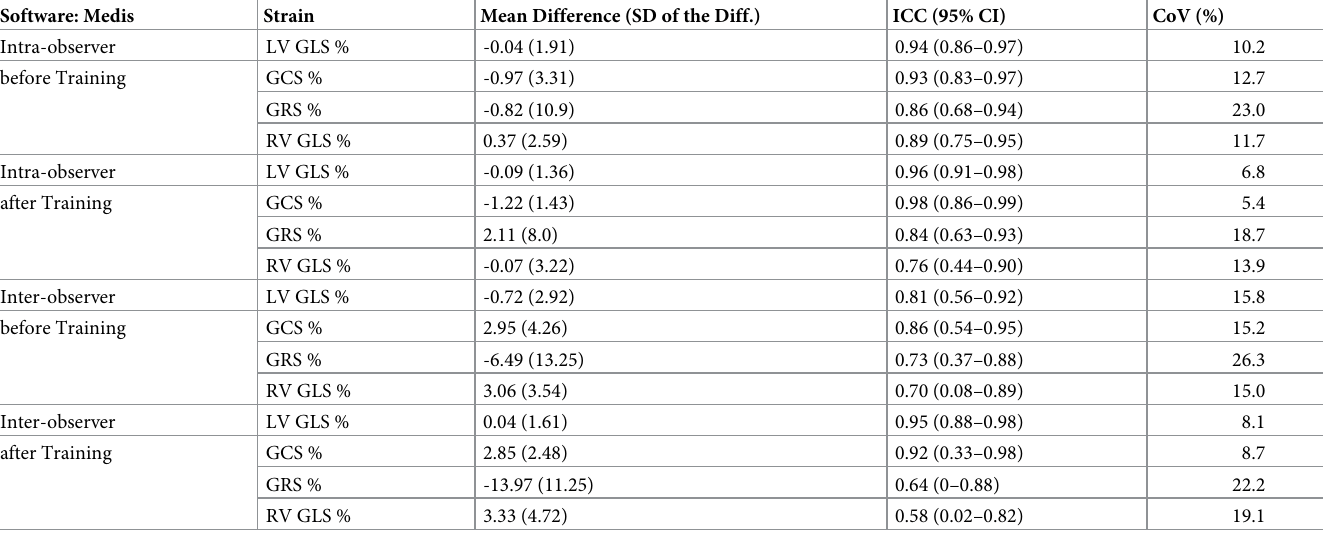
Table 3. Intra- and inter-observer reproducibility using Medis prior to and after training. Software: Medis